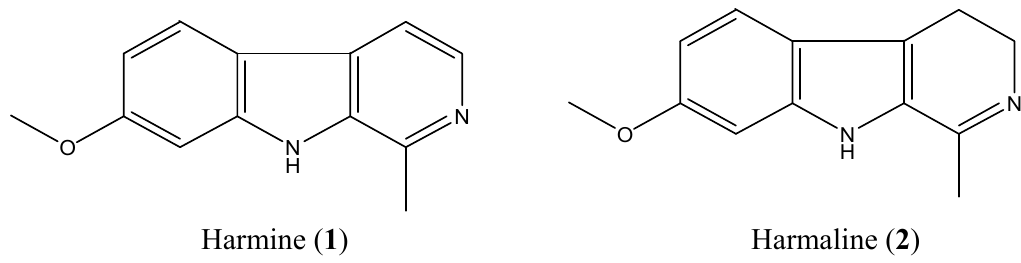
Figure 1. Chemical structures of harmine and